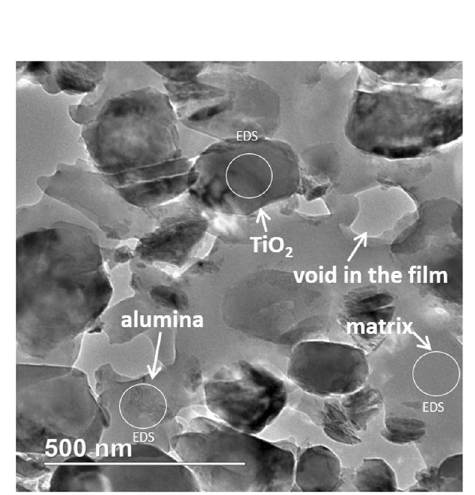
Fig. 6 STEM image of a lamella of 50 TiO 2 fi lm after exposure to the aqueous solution of Na 2 CrO 4 for 14 days at 60 °C. The image shows alumina and TiO 2 particles in the polymer matrix (white circles show examples of the areas of acquired EDS spectra).